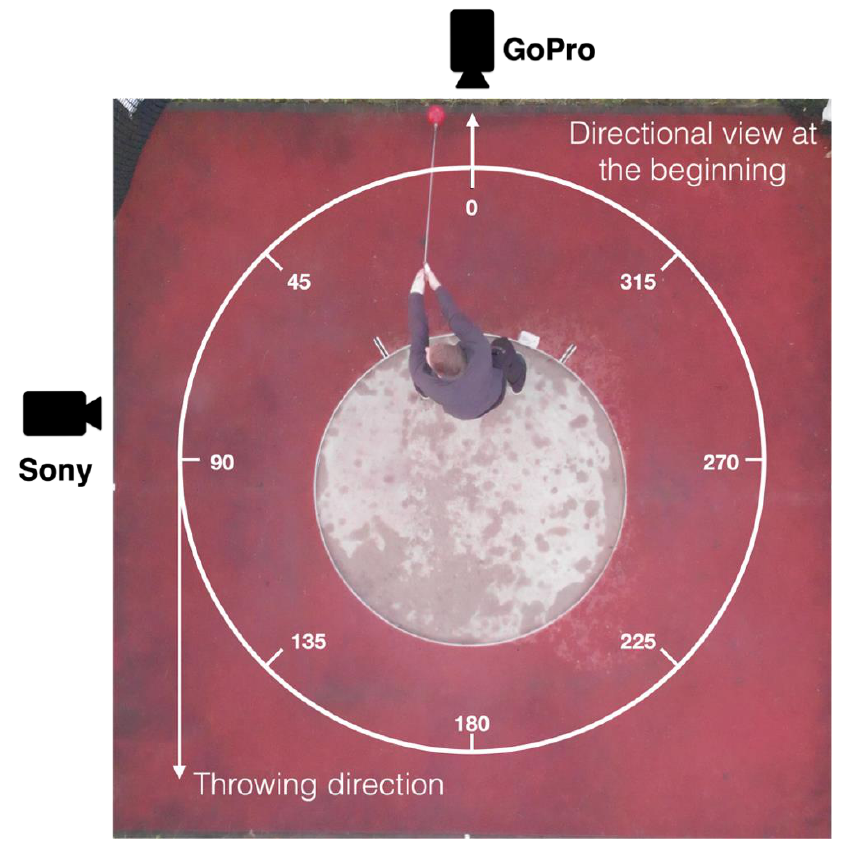
Figure 2. Study setup together with two video cameras. The division of the throwing circle in azimuth angles (°) is displayed.